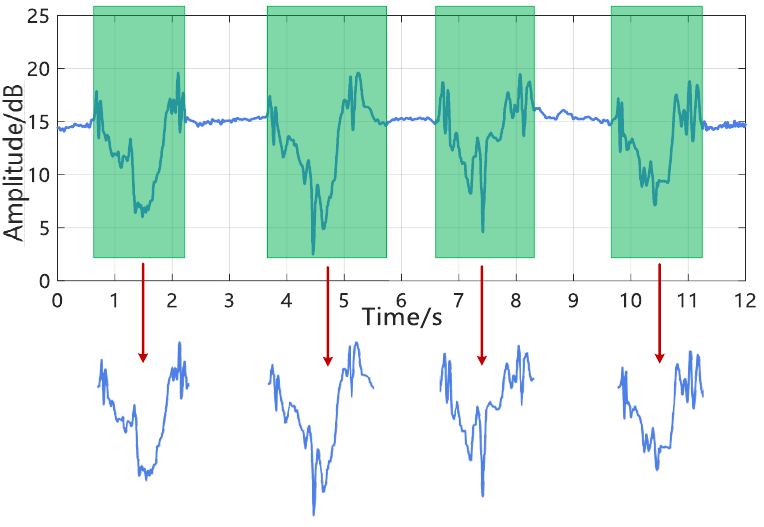
Figure 6. Gesture segmentation results.